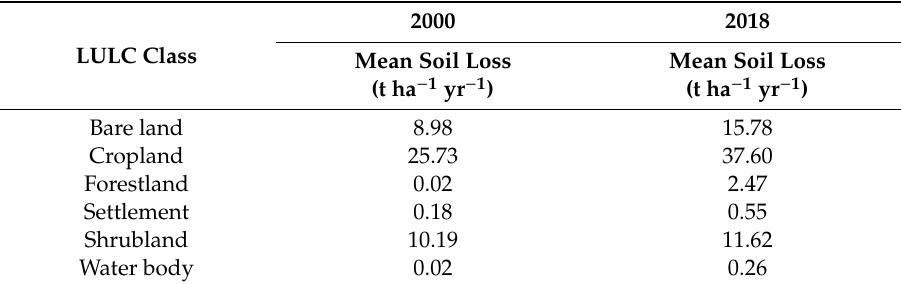
Table 8. Mean soil loss rate with respect LULC classes in the Erer